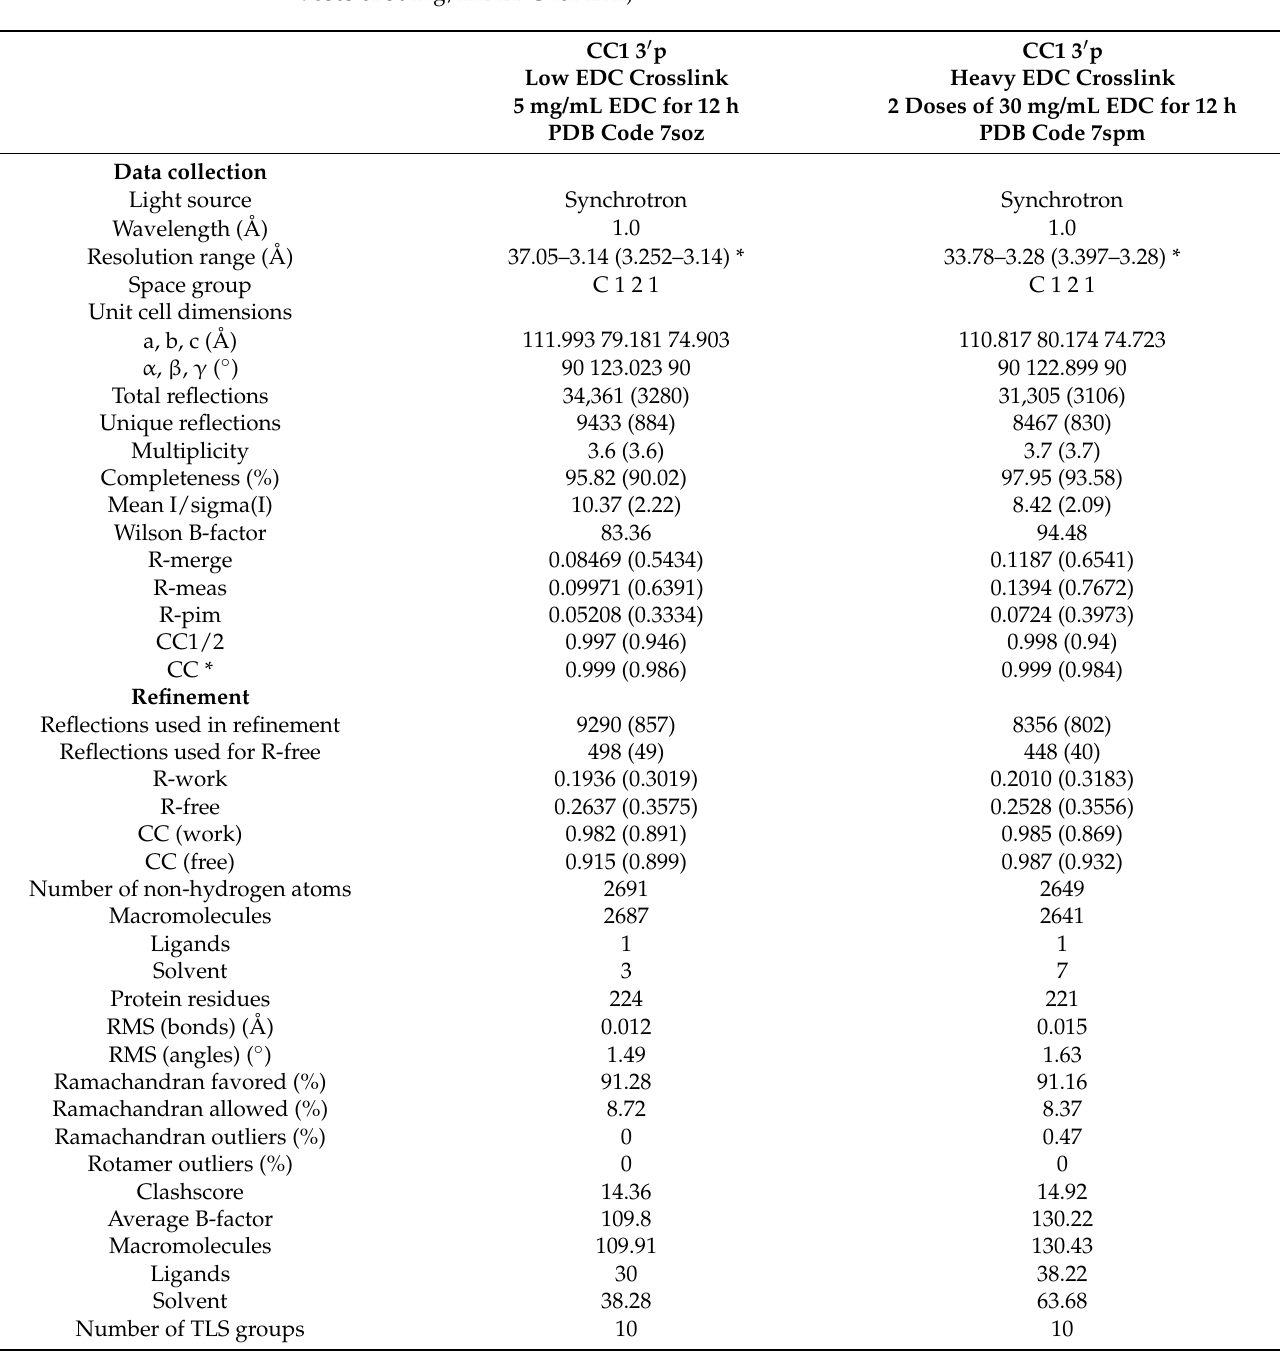
Table 2. X-ray diffraction statistics for the CC1 crystal with terminal 3 (cid:48) phosphates and low crosslink (5 mg/mL EDC for 12 h) and the CC1 crystal with terminal 3 (cid:48) phosphates and heavy crosslink (two doses of 30 mg/mL EDC for 12